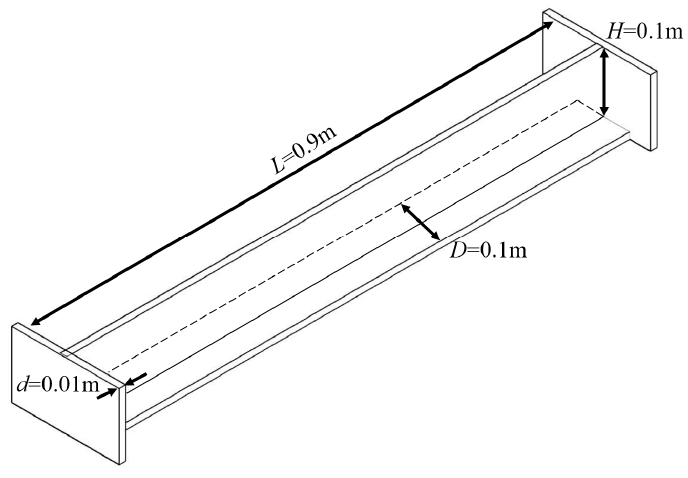
Figure 5. T-section prism size diagram.